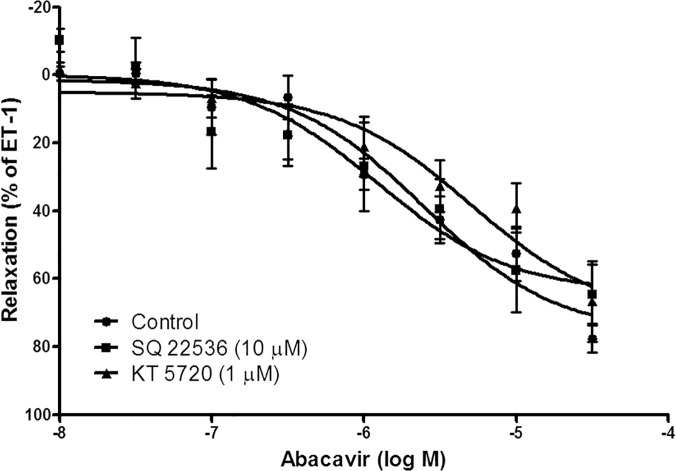
Role of the cAMP signaling pathway in abacavir-induced relaxation of rat basilar arteries.Rings of rat basilar arteries were treated with SQ 22536 (10 μM) or KT 5720 (1 μM) for 30 min. Rings without inhibitor treatment served as controls. Abacavir-induced relaxation of basilar arteries was then measured. Changes in tension were expressed as the percentage decrease in response to contraction caused by endothelin-1 (ET-1; 1–10 nM). Values are means ± S.E.M of five sets of experiments and statistical comparisons were made using ANOVA.